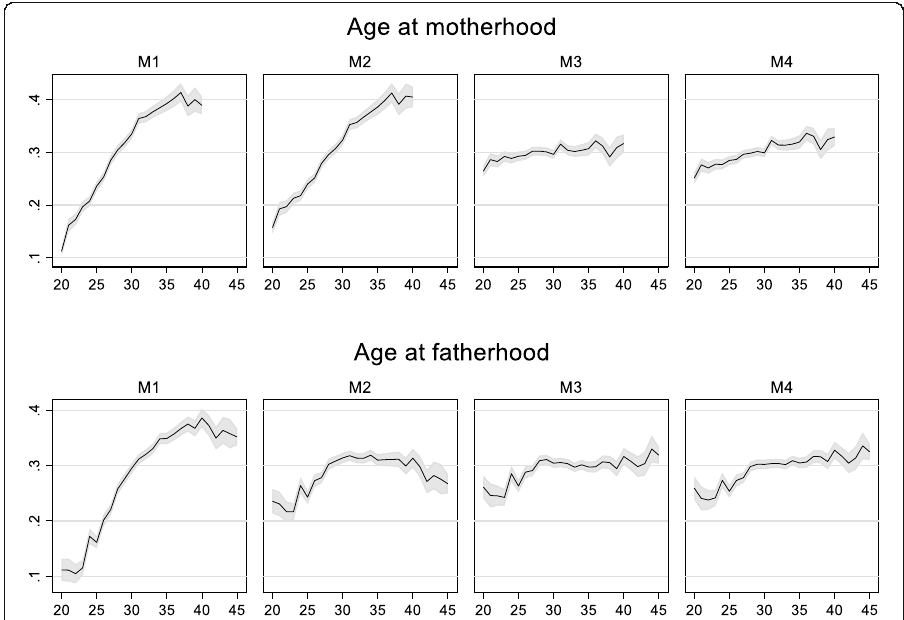
Fig. 2 Mother ’ s and father ’ s age at childbirth and probabilities of being enrolled in the academic track. Figures show the average linear predictions (with 95% confidence intervals), from linear probability models with robust standard errors. Model 1 estimates the gross effect of age at motherhood and fatherhood. Model 2 controls for age at childbirth of the other parent. Model 3 controls for both parents ’ social class and education. Model 4 includes additional controls for region of residence, trimester-year of interview, birth order, family size, birth abroad, age and